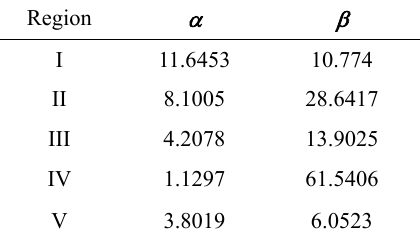
Table 1. Parameters of GAMMA distribution